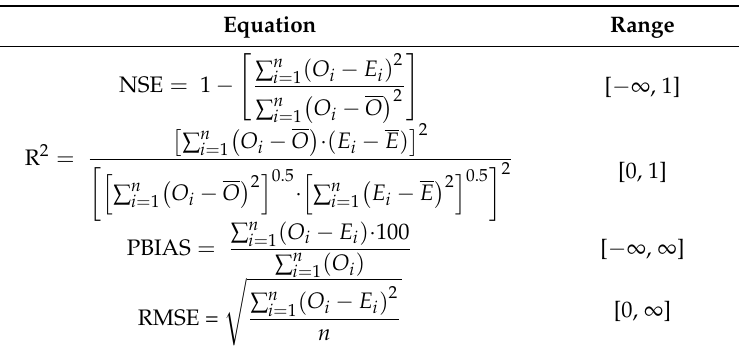
Table 2. Performance metrics.